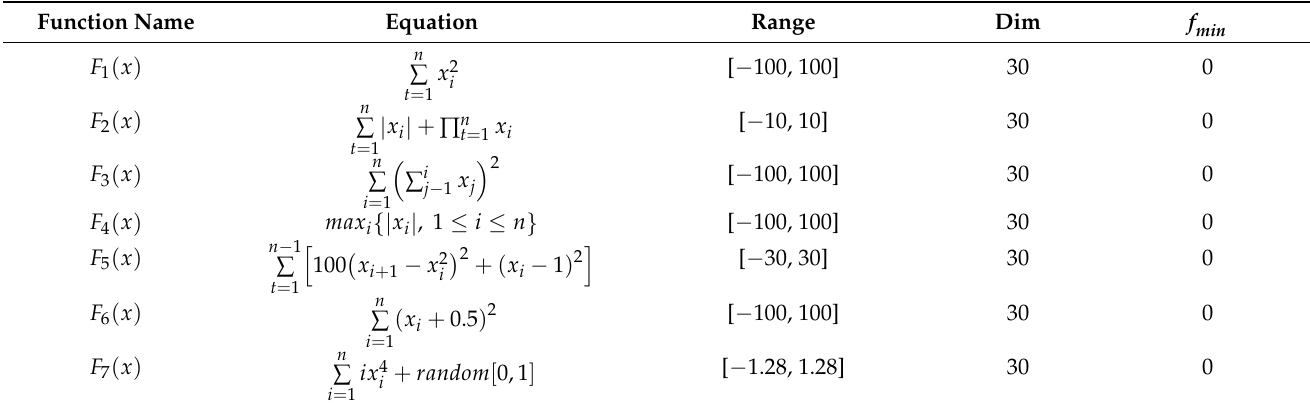
Table 2. Unimodal benchmark function equations.